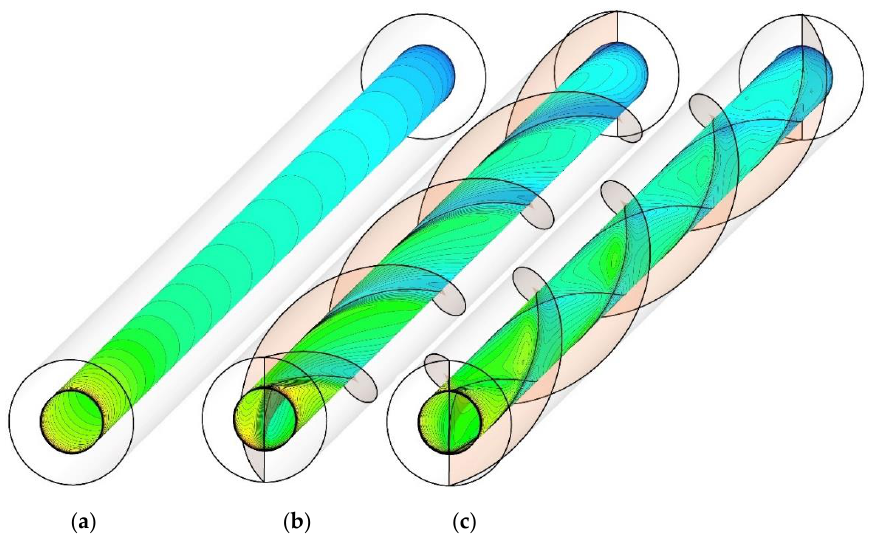
Figure 11. Temperature contours on the interface wall of the heat exchanger at Reynolds number of 250 for: ( a ) PHE; ( b ) Co-STT; and ( c ) Counter-STT.